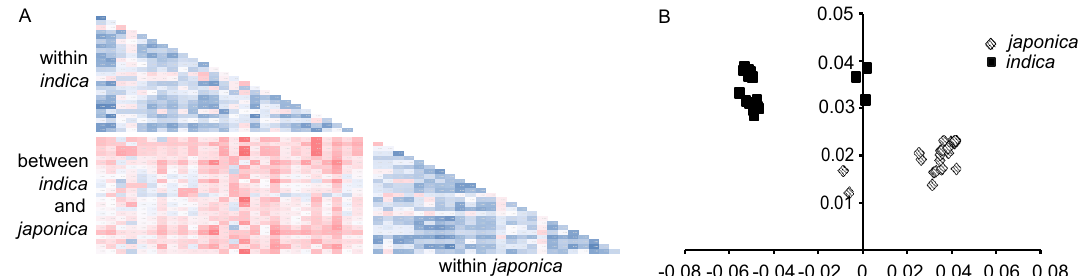
Figure 3. Significant differences in gene expression levels between indica and japonica . ( A ) Linear relationships in gene expression level between each sample. The R2 ranges from 0.75 (red) to 0.95 (blue). ( B ) The plot for principal variance component analysis of expression variations between indica and japonica plants. This figure was created using Microsoft Excel 2013 and Adobe Illustrator CS6.